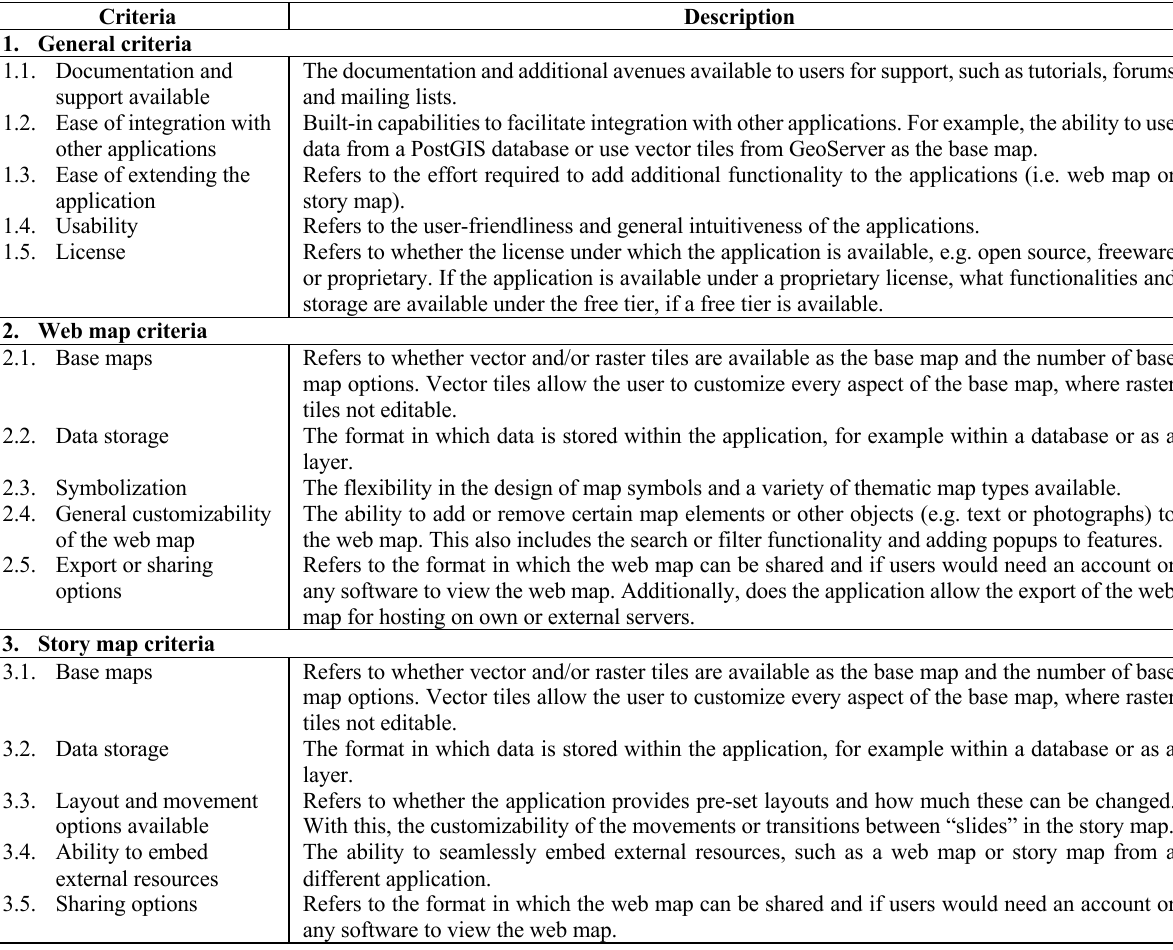
Table 1. Evaluation criteria for choosing tools to design web map and story maps for